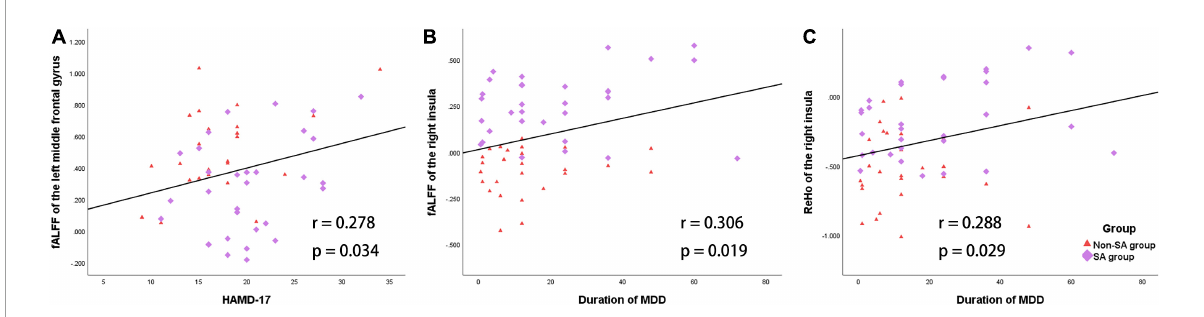
FIGURE3 Correlations between the fALFF/ReHo and the clinical characteristics in the patient group (SA and non-SA groups). (A) Mean fALFF values of the left middle frontal gyrus and HAMD-17 scores were positively correlated. (B) Mean fALFF values of the right insula and MDD episode duration were positively correlated. (C) Mean ReHo values of the right insula and MDD episode duration were positively